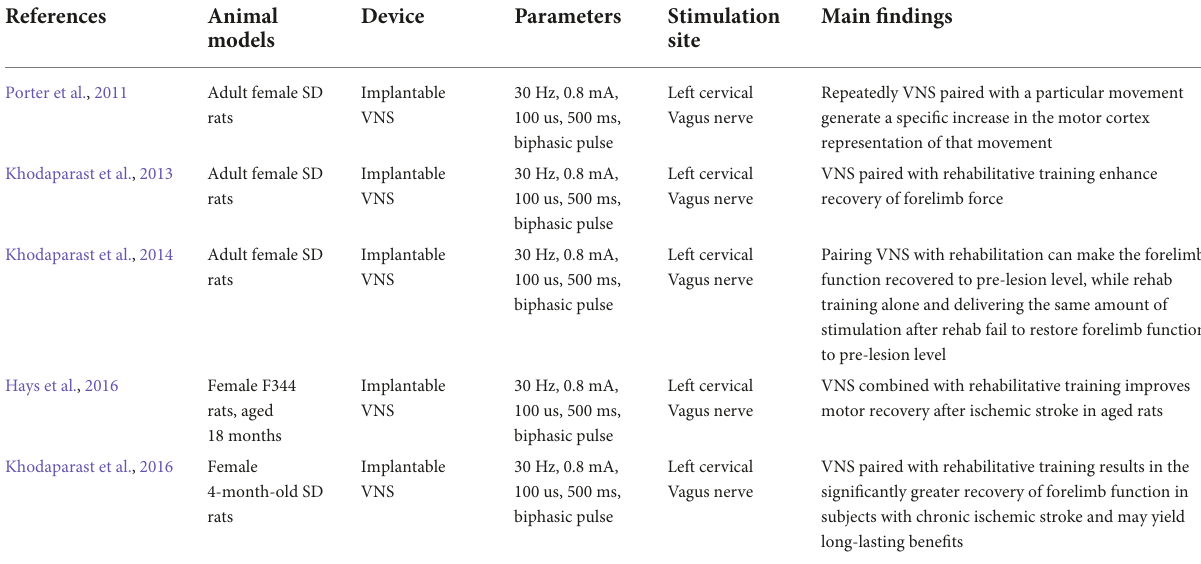
TABLE 1 Animal studies of VNS in post-stroke upper limb